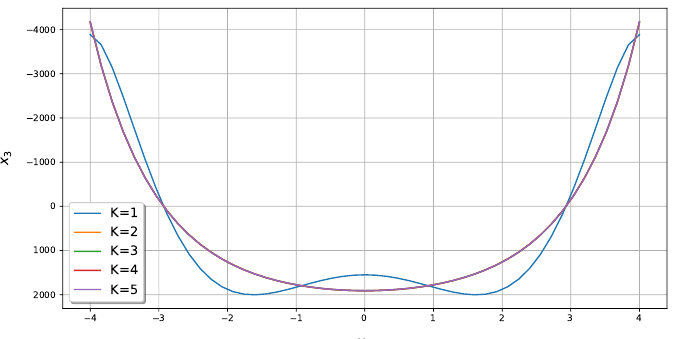
Figure 27. The bending moments M 11 in section x 2 = 0 of a rectangular plate with clamped edges for different number of approximations.